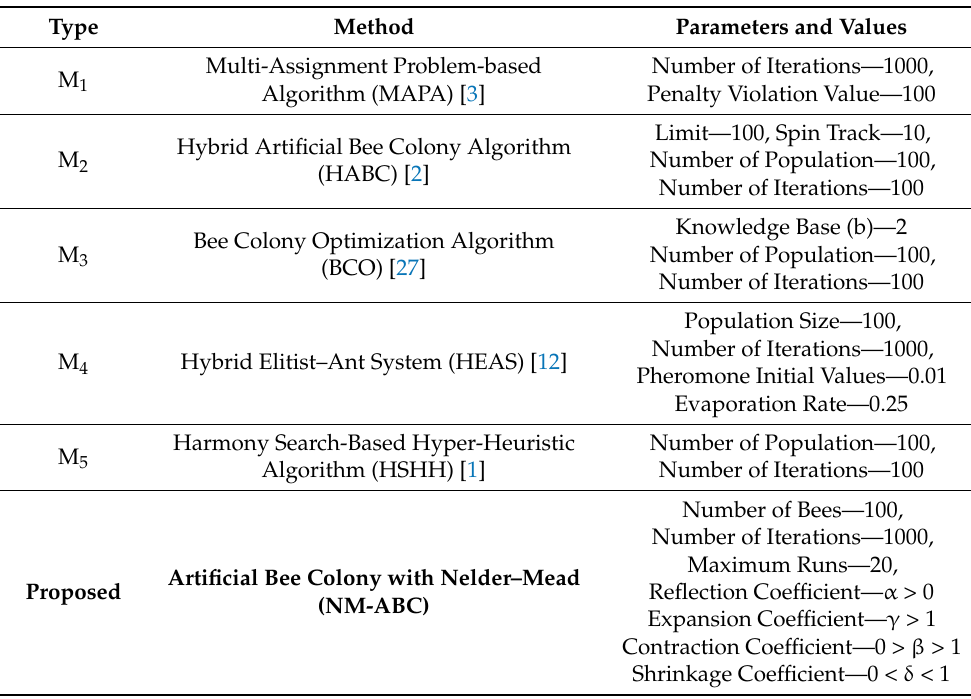
Table 2. Parameters setting of compared methods.